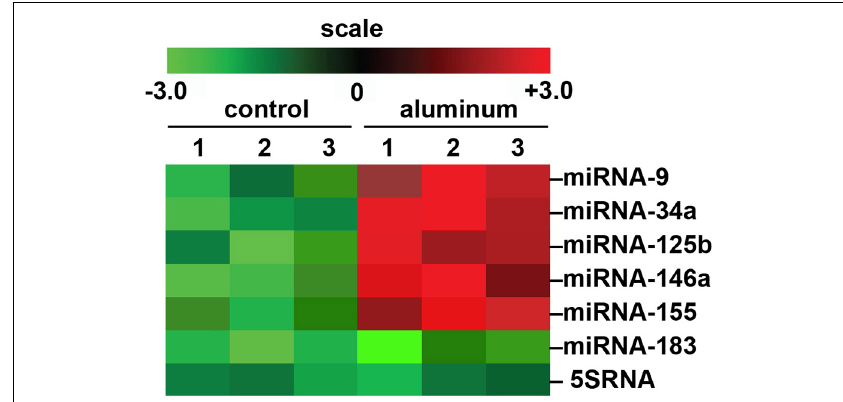
FIGURE 1 | Array-based cluster analysis of miRNA abundance in aluminum-fed Tg2576 mice vs. controls. In these experiments the brain (cortex) of 3 month-old Tg2576 mice fed aluminum-enriched diets were analyzed for miRNA speciation compared to age-matched controls (receiving standard diets); methodologies for aluminum-treatment of transgenic animals have been previously described in detail (Praticò et al., 2002; Zhang et al., 2012). Aluminum treatment of other transgenic murine AD models such as the amyloid over-expressing APP/PS1 show similar intensification of AD-type changes (Zhang et al., 2012). The up-regulation of the pro-inflammatory quintet of miRNA-9, miRNA-34a, miRNA-125b, miRNA-146a, and miRNA-155, depicted here, were amongst the most significantly increased miRNAs found to be 2- to 5-fold above normal diet, age-matched controls (compared to an unchanging internal control miRNA-183 and 5SRNA in the same samples). The results strongly suggest a potential contribution of aluminum to the AD processes associated with miRNA-mediated down-regulation of gene expression in the sporadic AD brain as is widely observed (Colangelo et al., 2002; Lukiw and Pogue, 2007; Ginsberg et al., 2012; Pogue et al., 2012; Alexandrov et al., 2013). Importantly, other common environmental neurotoxic divalent metals such as calcium, cadmium, copper, iron (2 + ), mercury, nickel, and lead, and neurotoxic trivalent metals such as boron, chromium, gadolinium, indium, iron (3 + ), and yttrium do not exhibit this potentially pathogenic effect (Walker et al., 1989; Alexandrov et al., 2005; Lukiw, 2010; unpublished observations); N = 3 control and N = 3 aluminum-treated mice; methodologies and data analysis have been extensively described elsewhere (Lukiw and Pogue, 2007; Alexandrov et al.,